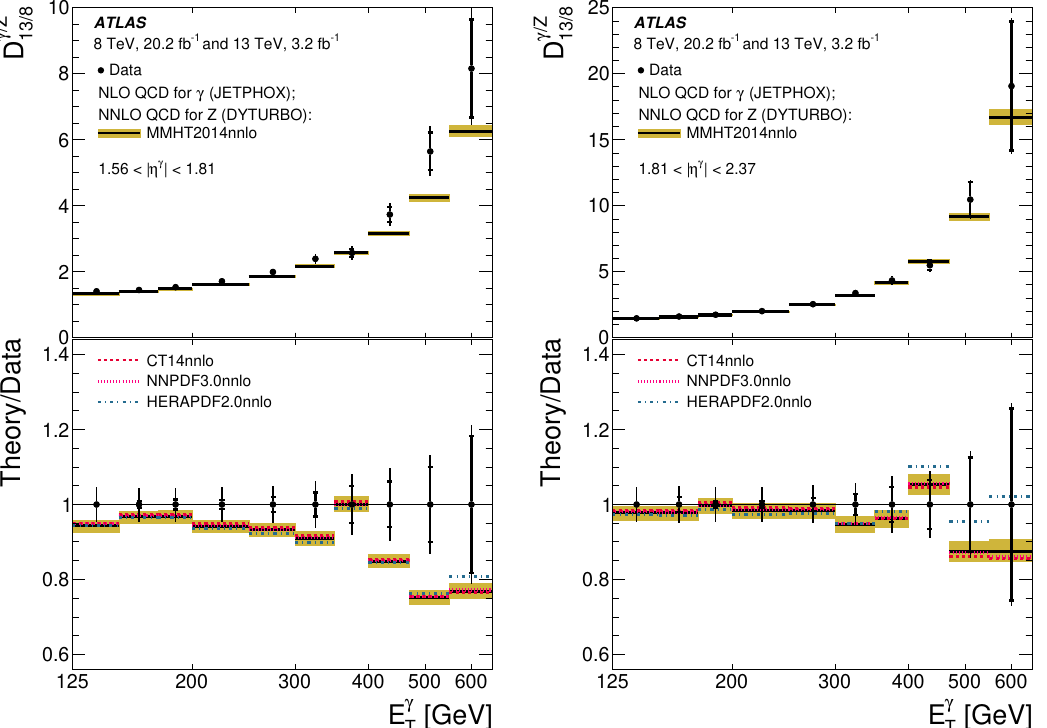
Figure 9 . The measured D (cid:13)=Z (dots) as a function of E (cid:13) in di(cid:11)erent regions of j (cid:17) (cid:13) j . The pQCD T 13 = 8 predictions based on the MMHT2014nnlo PDFs (black lines) are also shown. The inner (outer) error bars represent the statistical (total) uncertainties. The shaded band represents the theoretical uncertainty in the predictions. For most of the points, the error bars are smaller than the marker size and, thus, not visible. The lower part of the (cid:12)gures shows the ratio of the pQCD predictions based on the MMHT2014nnlo PDFs to the measured D (cid:13)=Z (black lines). The ratios of the pQCD 13 = 8 predictions based on di(cid:11)erent PDF sets to the measured D (cid:13)=Z are also included. 13 = 8